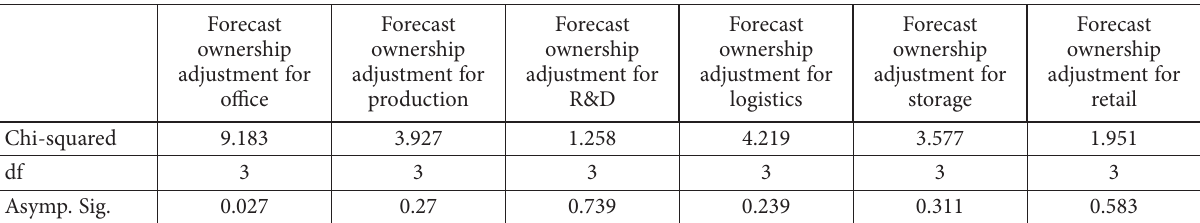
Table 7. Kruskal–Wallis test statistic using structural change clusters as the grouping variable